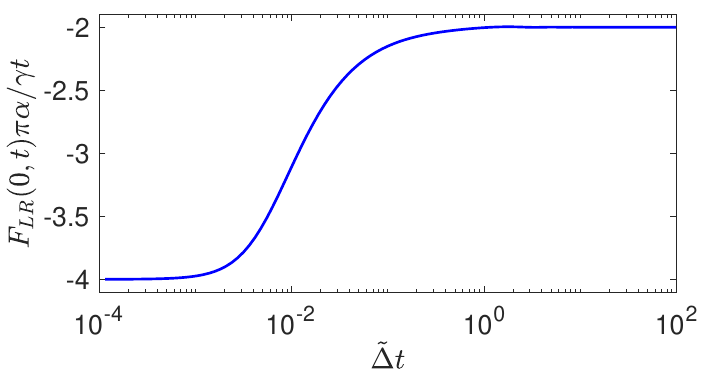
Figure 3: Time dependence of the decay rate of charge density wave order parameter for α ˜ ∆ / ˜ v = 0.01, (see Eq. (32)). Apart from the renormalization of its equilibrium value ˜ ∆ → ˜ ∆ K , the time dependence is completely independent of the forward scat- tering